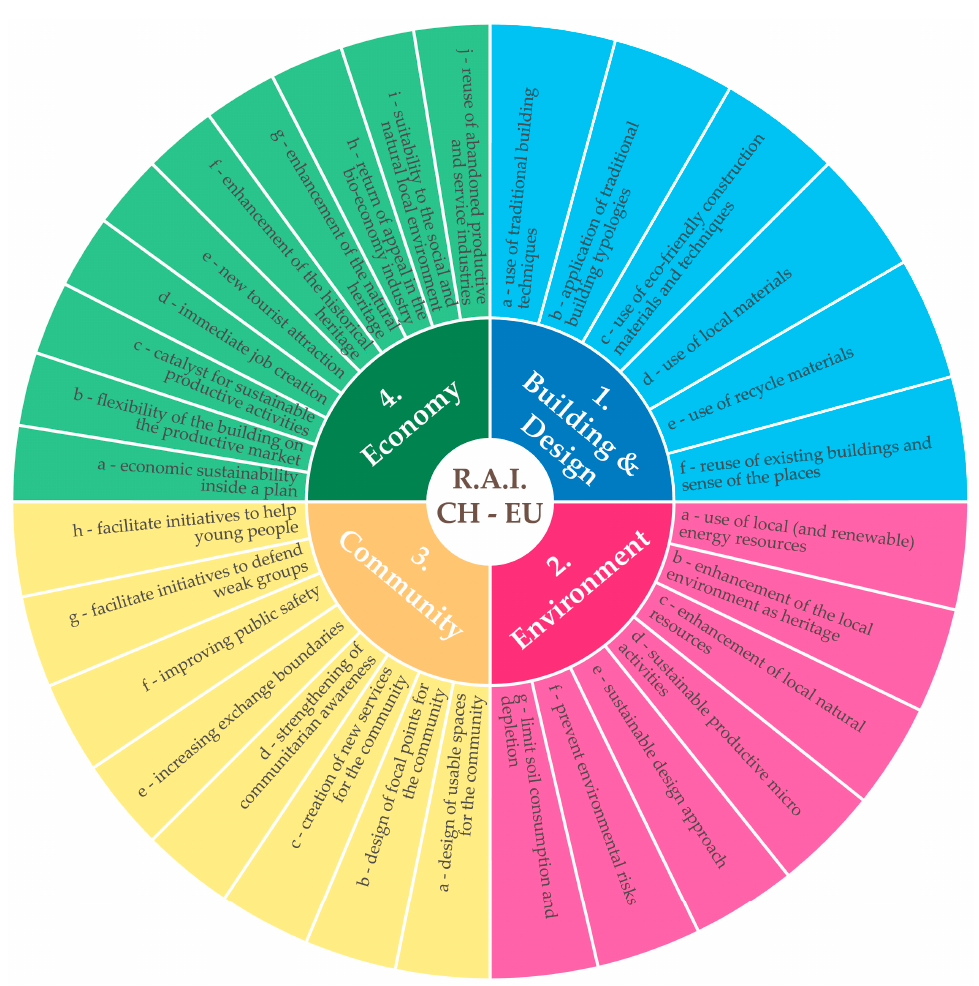
Figure 1. Semantic diagram: goals and strategies for sustainable projects in rural areas.